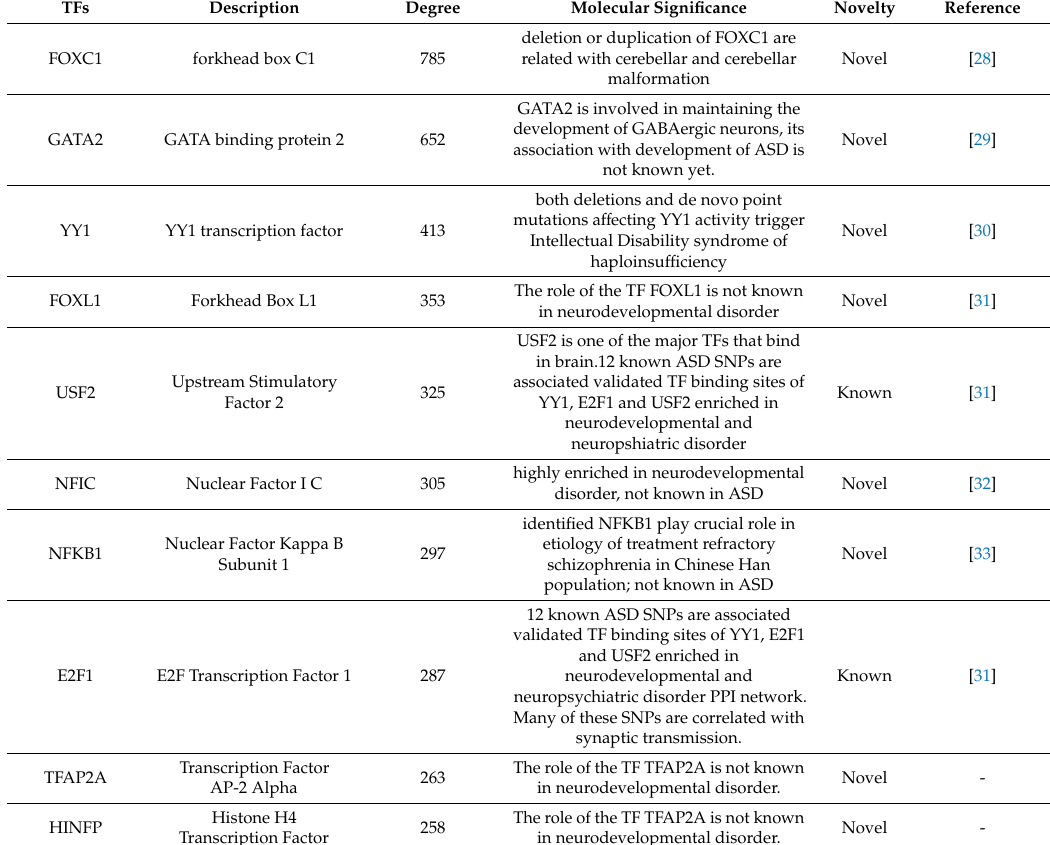
Table 4. Post-transcriptional regulatory biomolecules identified from di ff erentially expressed genes–transcriptional interaction